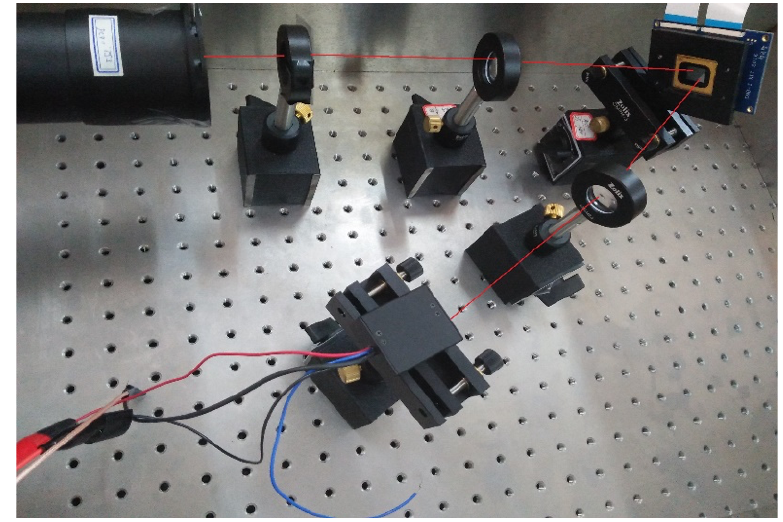
Figure 2. Photo of the light path of single-photon compressed imaging